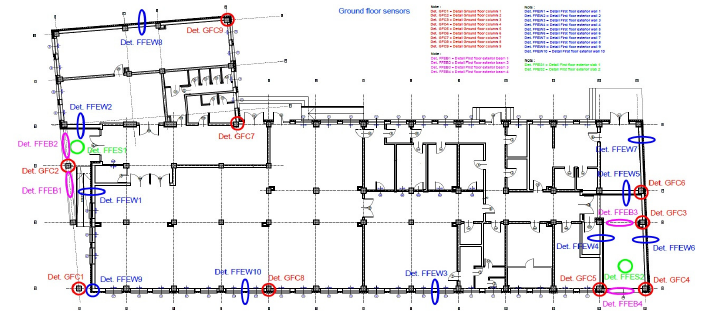
Fig. 10. Monitoring system plan